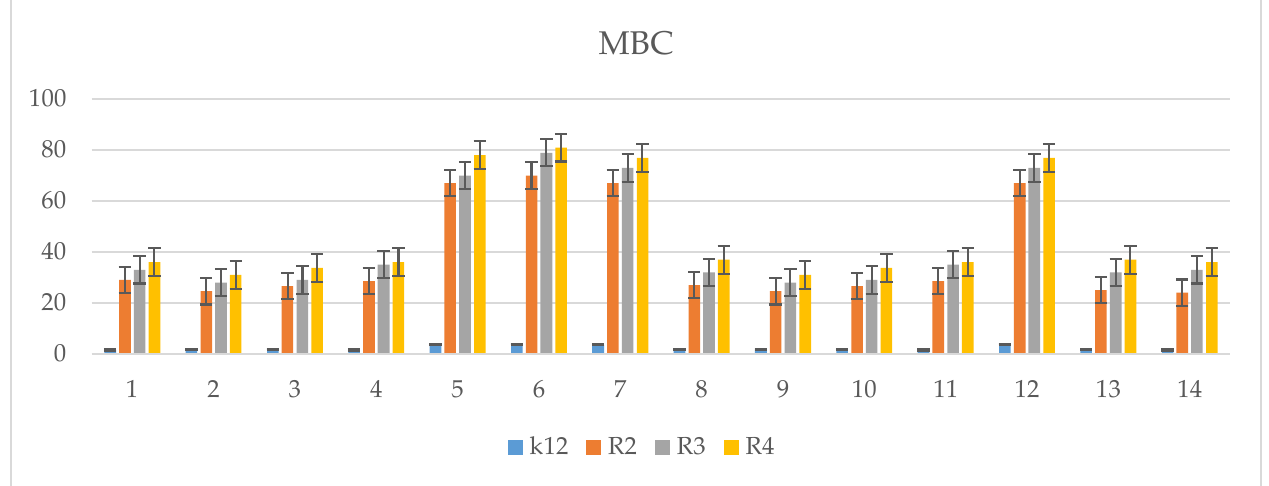
Figure 5. Minimum bactericidal concentration (MBC) of the β -phosphonate derivatives. The x -axis features compounds 1 – 14 used sequentially. The y -axis shows the MIC value in µg/mL −1 . Investigated strains of E. coli K12 as control (blue), R2 strains (orange), R3 strain (grey), and R4 strain (yellow). The y -axis shows the MBC value in µg/mL − 1 . The order in which the compounds were applied to the plate is shown in Supplementary Materials Figure S1.